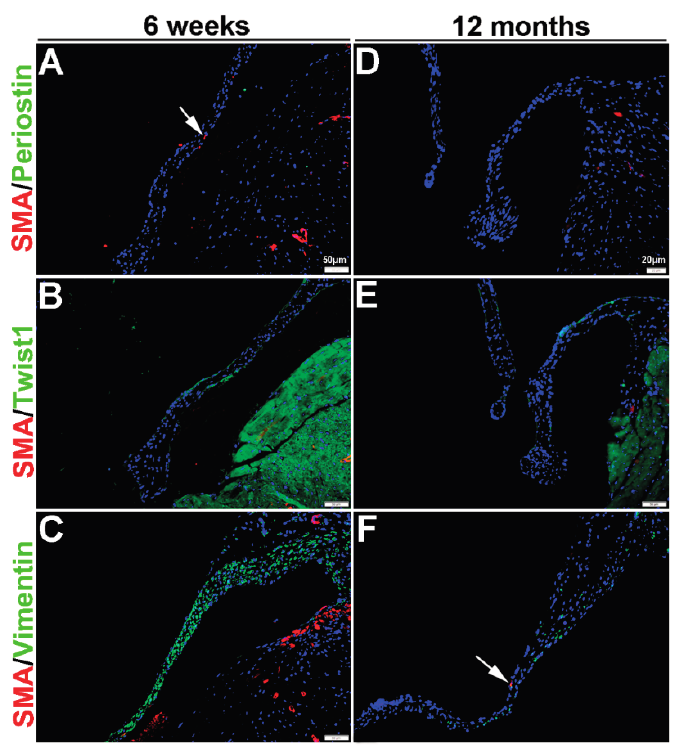
Figure 4. Characterization of VIC phenotypes in adult and aging mitral valves. Immunohistochemistry to show expression of smooth muscle α -actin (SMA) with Periostin ( A , D ), Twist1 ( B , E ) and Vimentin ( C , F ) in cells within the mature mitral valve leaflets. Arrows indicate SMA expression (red).